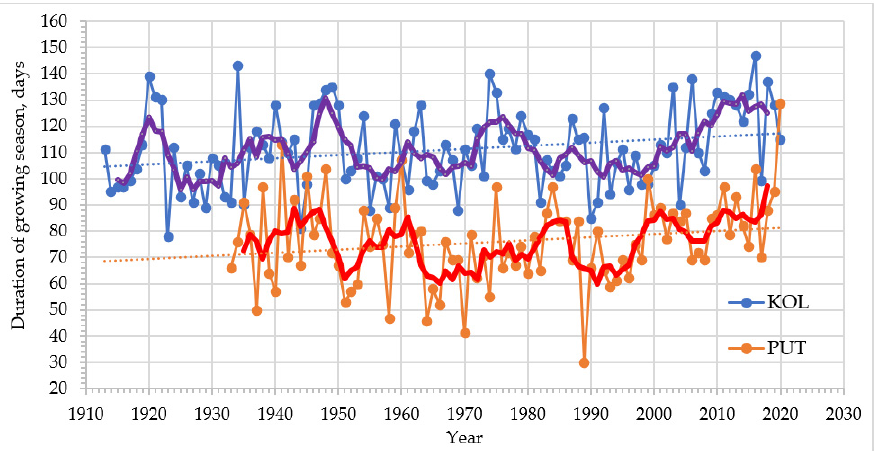
Figure 8. Changes of the period with air temperatures above 5 °C on the slopes of the Kola Peninsula (KOL) and the Putorana Plateau (PUT) in the years 1913–2020.